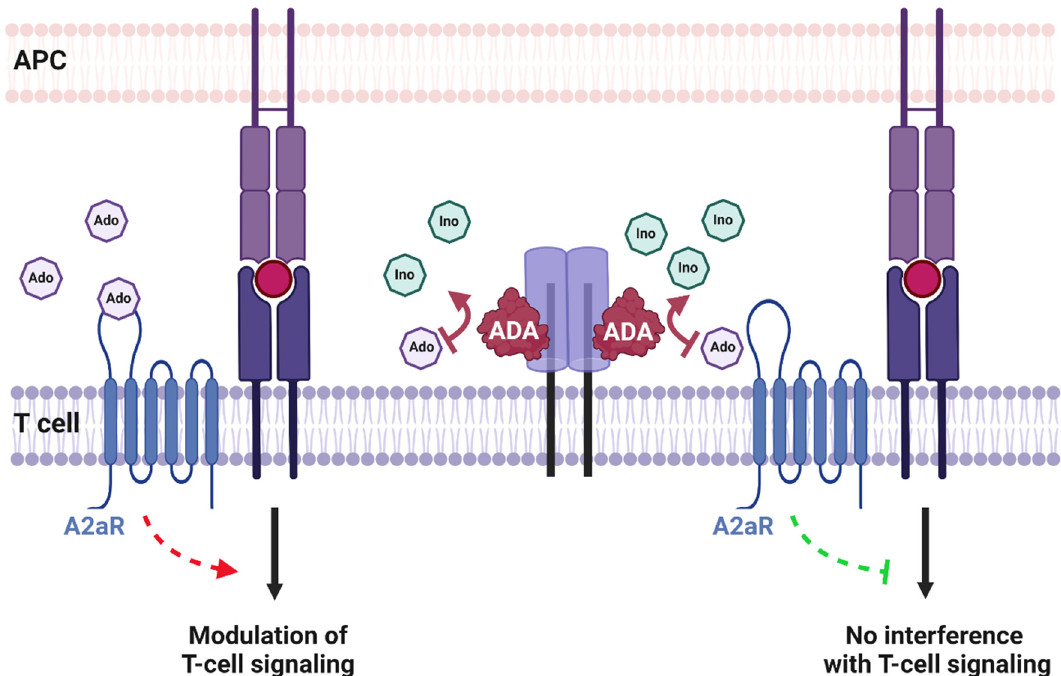
Figure 3. Interaction of CD26 with adenosine deaminase (ADA). Extracellular adenosine (Ado) interferes with T-cell receptor signaling by binding to the adenosine receptor 2a (A2aR) expressed on T cells (A). ADA anchored to CD26 metabolizes immunosuppressive adenosine to inosine (Ino) and in this way facilitates T-cell activation and differentiation to effector/memory T cells.